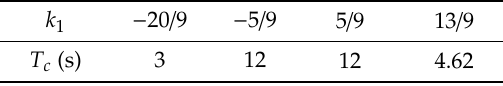
Figure 5. Average velocity distribution v sr as a function of radius R d for different parameters k 1 : ( a ) k 1 = − 20/9; ( b ) k 1 = − 5/9; ( c ) k 1 = 5/9; and ( d ) k 1 = 13/9.